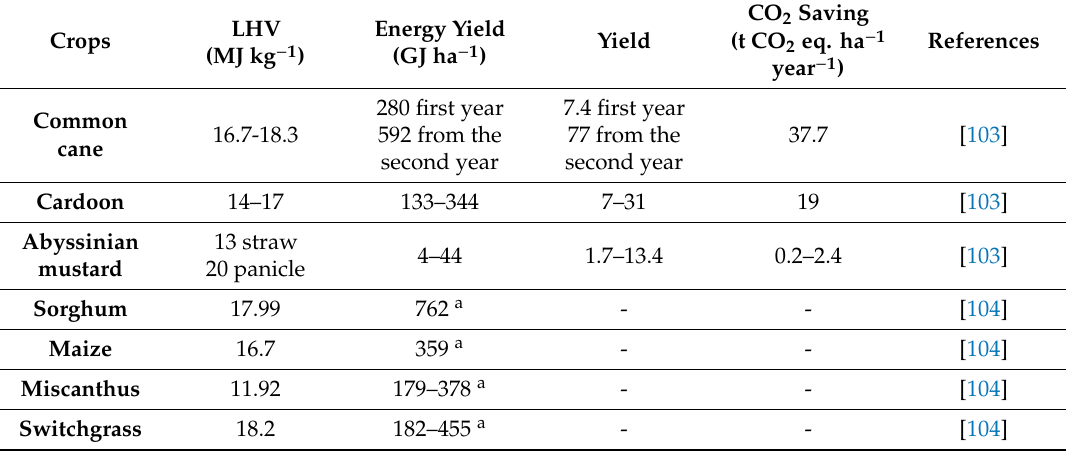
a Estimated using dry matter (Table 3) and